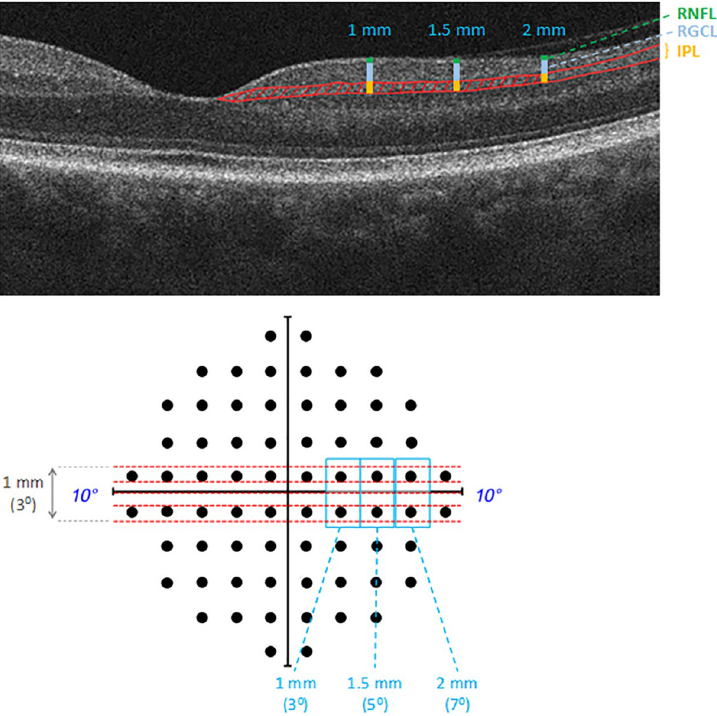
Fig 1. Studied imaging parameters of the IPL for testing functional associations. The imaging parameters analyzed on OCT scans included the thickness of the IPL (shown by yellow bar), RGCL (shown by blue bar), and RNFL (shown by green bar) on the nasal and temporal sides at a distance of 1, 1.5, and 2 mm from the center of the macula (shown is the nasal side). The IPL was also analyzed in the same retinal locations by linear densitometry. In addition, the IPL density was analyzed in the area within 2 mm (approximately 7 0 ) from the macula center on nasal and temporal sides of the OCT scans (red patterned area). For testing the functional association of these imaging parameters, corresponding total deviation values on 10–2 visual fields were used, including one below and one above the horizontal midline within 8 0 (shown in blue-colored boxes) on nasal and temporal fields. Red dashed lines illustrate the approximate position of 5-line raster scans that were obtained within a 6 × 1 mm 2 area, the vertical span of which (1 mm) corresponds to an angular spacing of approximately 3 0 . The thickness and linear densitometry values obtained at 1, 1.5, and 2 mm from the macula center on these scans were tested against the average of total deviation scores at corresponding test points (approximately 3, 5, and 7 0 ); however, the area densitometry values were tested against the average of these